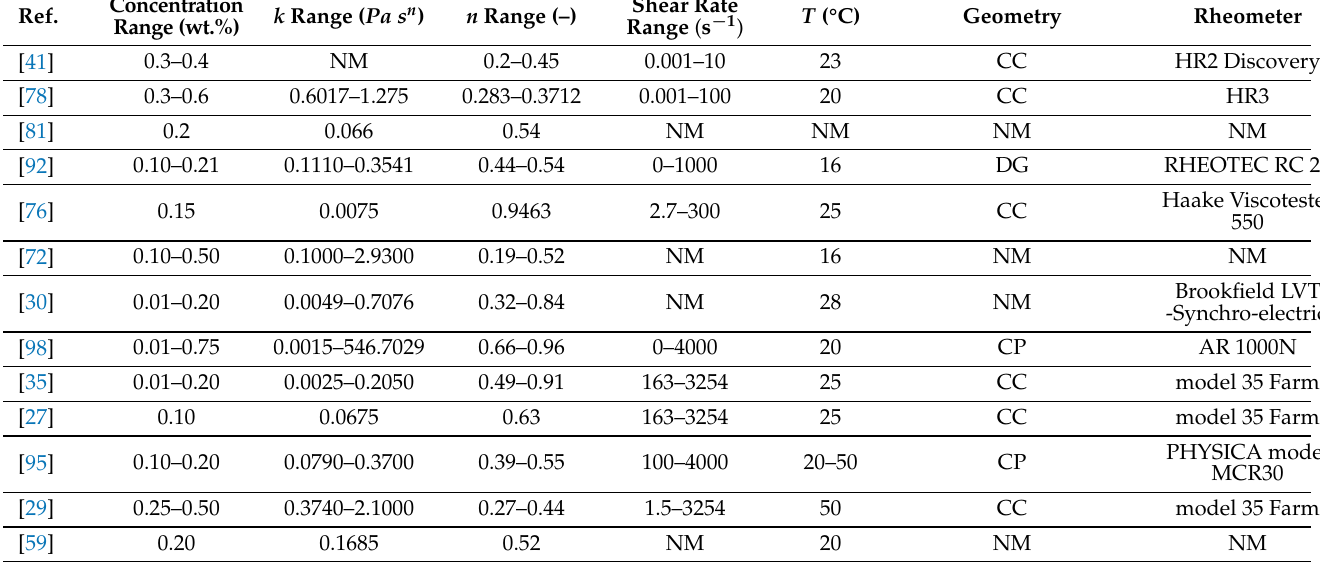
Table 9. Different rheological parameters for XG from the available literature.